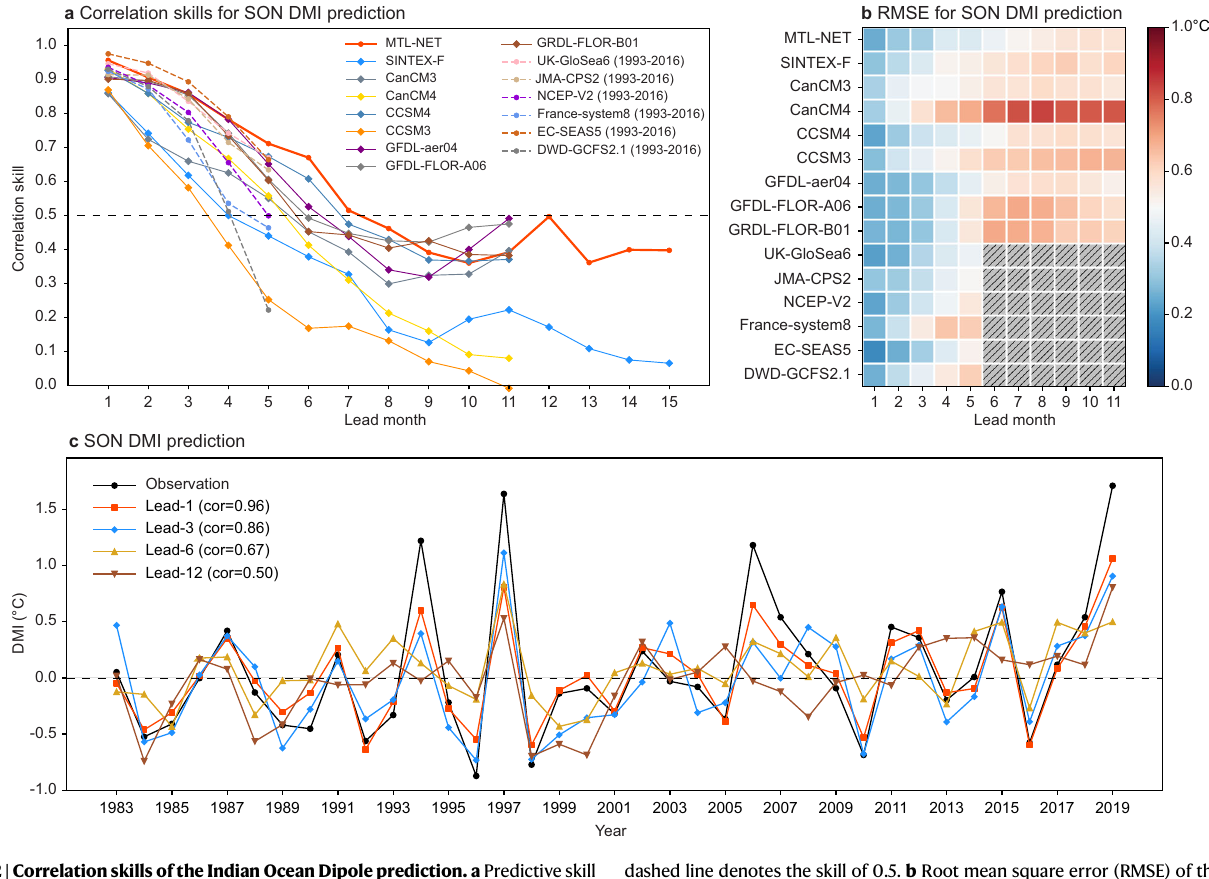
dashed line denotes the skill of 0.5. b Root mean square error (RMSE) of the SON DMIpredictionbasedonthe MTL-NETand each dynamicalmodelforecastsystem. The diagonal line represents the model does not have prediction at this lead time. c The SON DMI based on the observations (black line) and 10-member ensemble meanpredictionsofMTL-NETatleadtimeof1,3,6and12months(red,blue,yellow and brown lines),